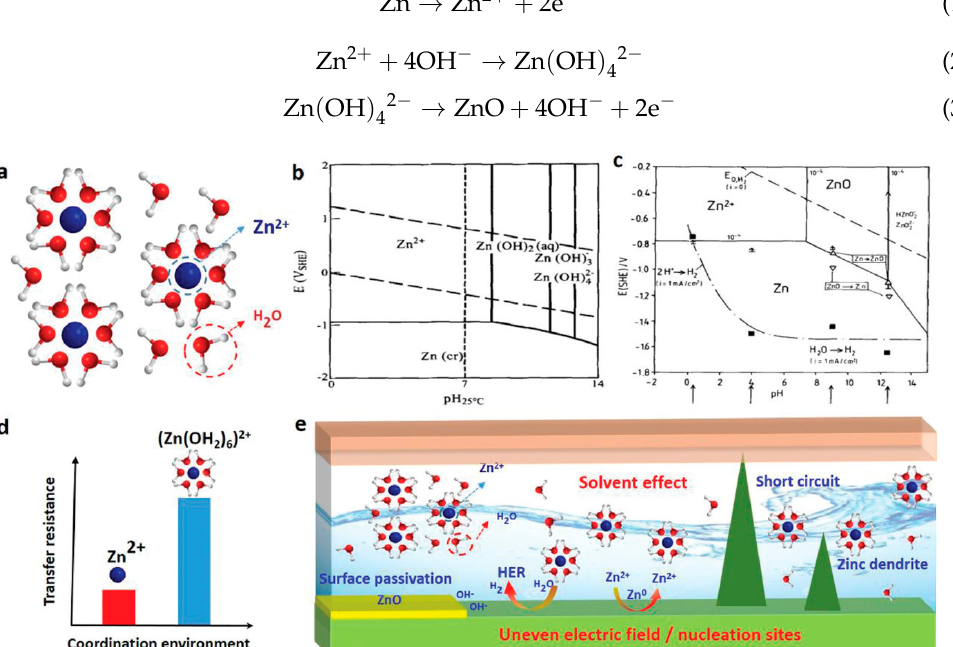
Figure 2. ( a ) The coordination environment of Zn 2+ in aqueous electrolyte. ( b ) Pourbaix diagram of the Zn/H 2 O system. ( c ) Pourbaix diagram of the Zn/H 2 O system including HER overpotential changes. ( d ) Comparison of transfer resistance with different coordination environments. ( e ) Schematic diagram of the impact factors on the decay of zinc anode performance. Reproduced with permissions from Ref. [38]. Copyright © 2020 WILEY-VCH.